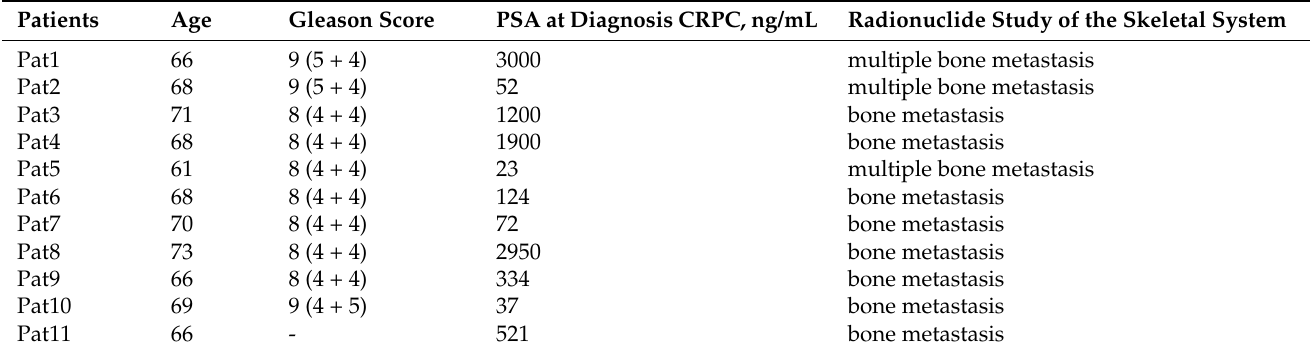
Table 11. Clinical and pathological characteristics of patients with CRPC included in the